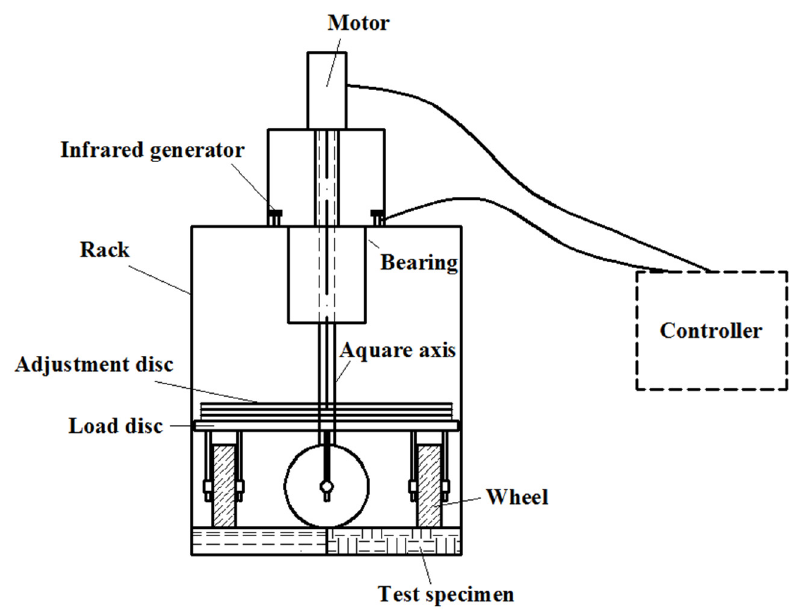
Figure 2. Wear test.